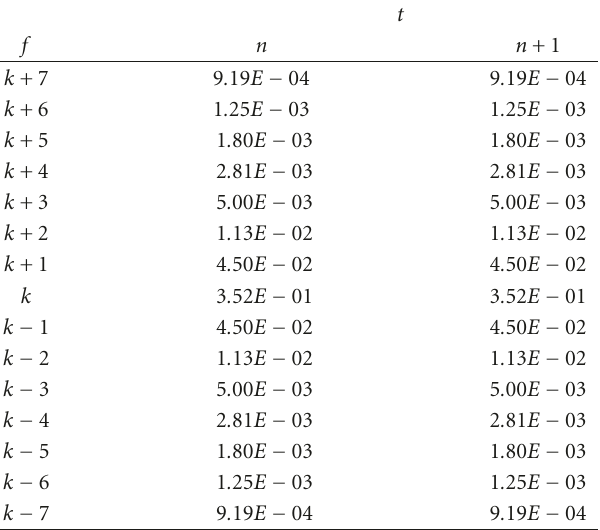
Table 1: Mean interference power table of